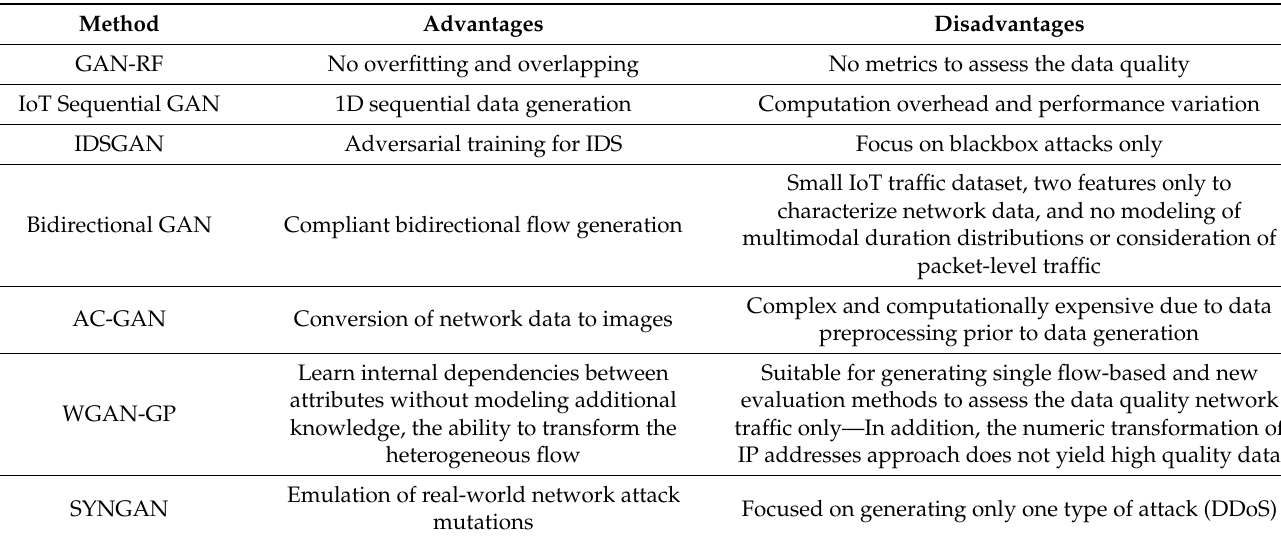
Table 4. Advantages and Disadvantages of Data-driven Learning